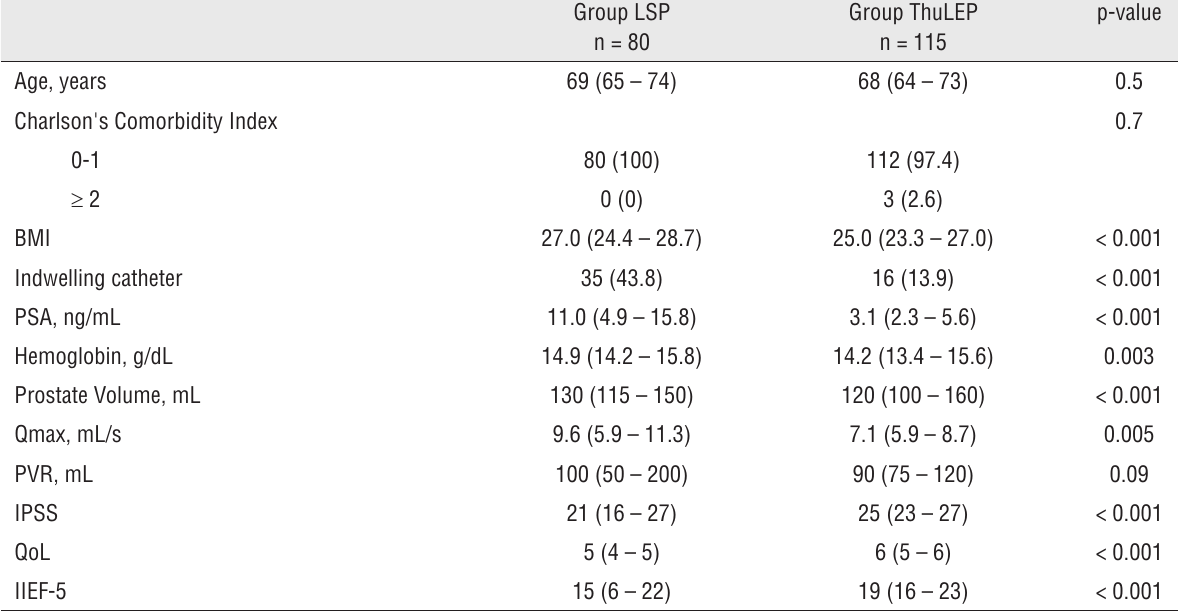
Table 1 - Distribution of baseline characteristics of patients in the treatment